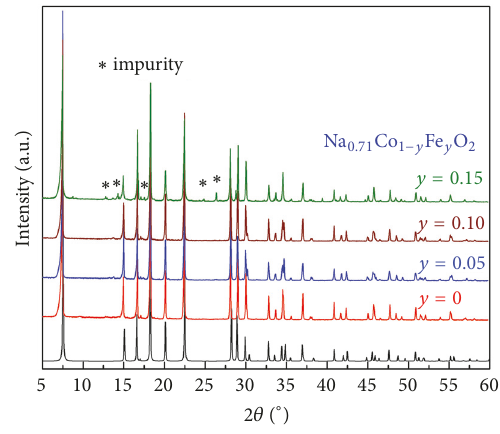
Figure 2: (Color online) XRD pattern of the Na 0.71 Co 1−𝑦 Fe 𝑦 O 2 ( 𝑦 = 0, 0.05, 0.10 and 0.15) powder samples. Black line: reference data obtained from the ICSD